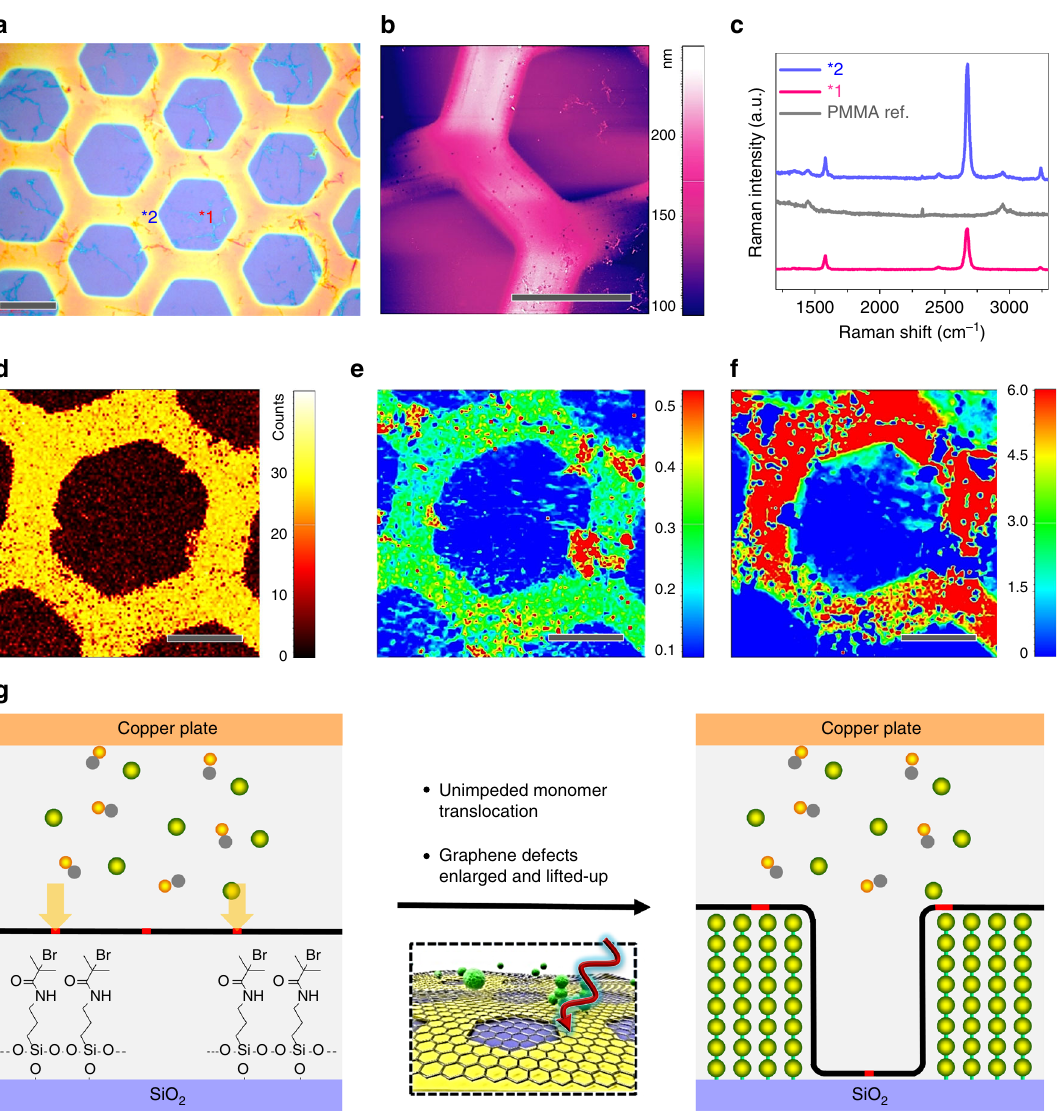
Fig. 3 Translocation of MMA through graphene driven by SI-CRP. a Optical micrograph and b AFM topographic scan of PMMA grafted on graphene-BiBB- SiO 2 . c Representative Raman spectra of regions ∗ 1 and ∗ 2 as marked in a . d Raman mapping with the integrated intensity at 2950 cm − 1 (PMMA). e Raman mapping of the integrated intensities ratio of I D / I G (graphene). f Raman mapping of integrated intensities ratio of I 2D / I G (graphene). g Scheme of the experimental set-up and the translocation of MMA through graphene induced by SI-CRP. Scale bars in a , b : 40 µ m; in d – f : 20 µ